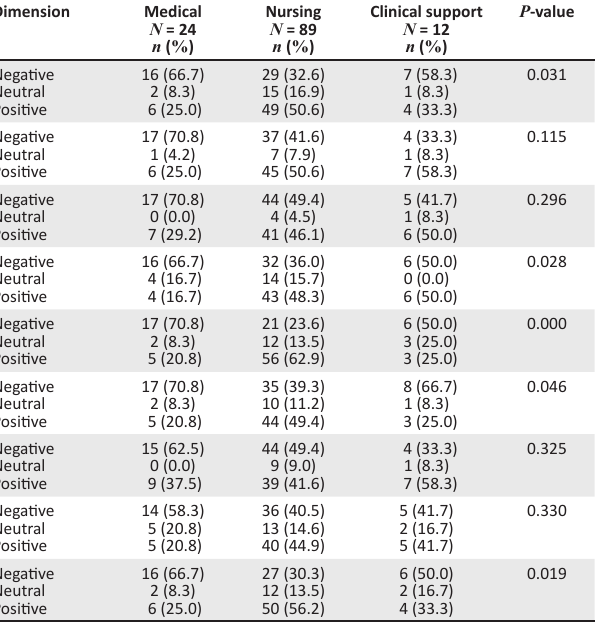
TABLE 4: Analysis of the nine quality dimensions and employment status.